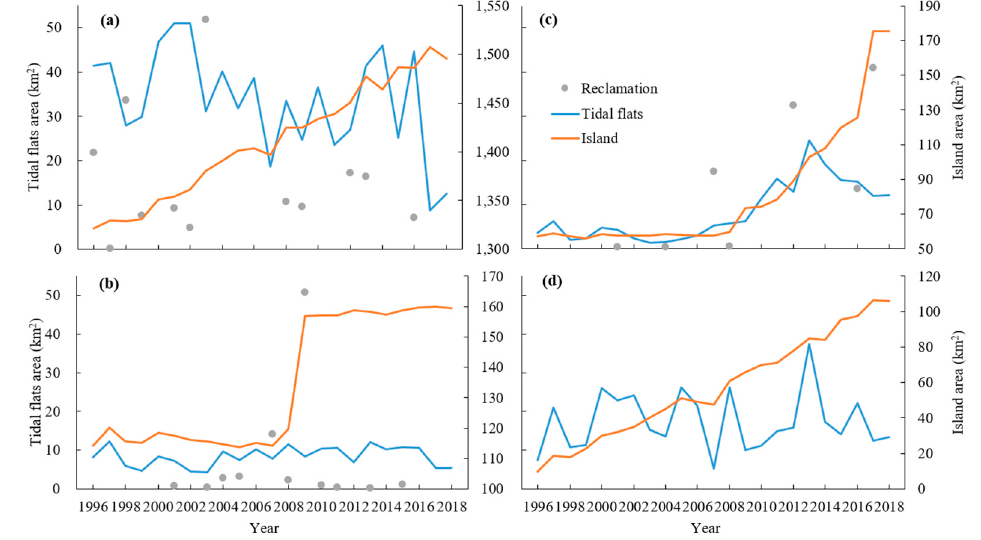
Figure 6. Dynamic of tidal flats in YRE from 1996 to 2018, shown for every 4 years, except for 2018.